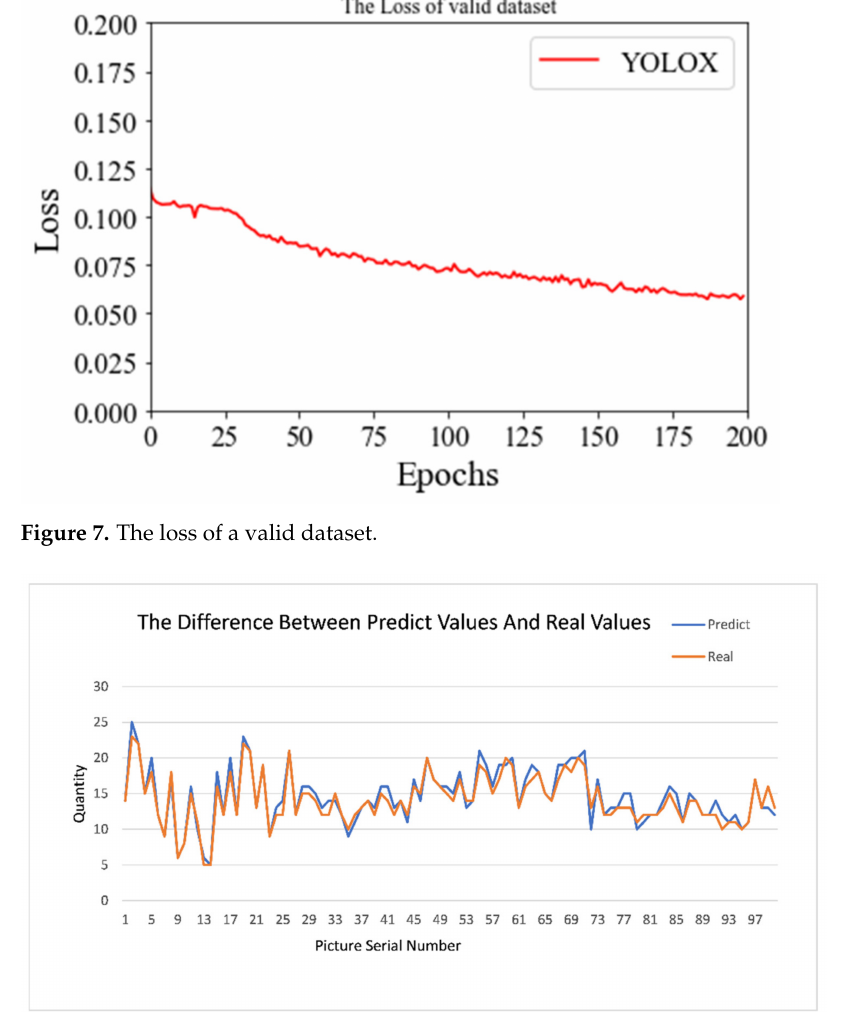
Figure 8. The difference between predict values and real values.